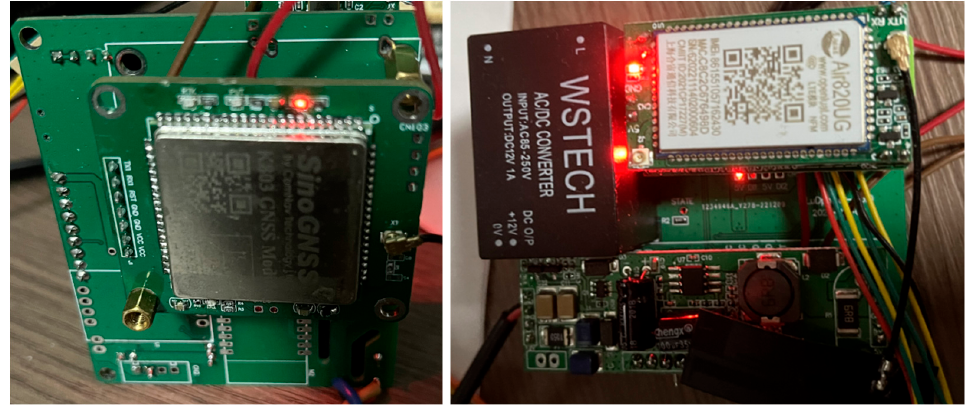
Figure 8. A designed GNSS-based sensor unit, utilized by EMULSION.